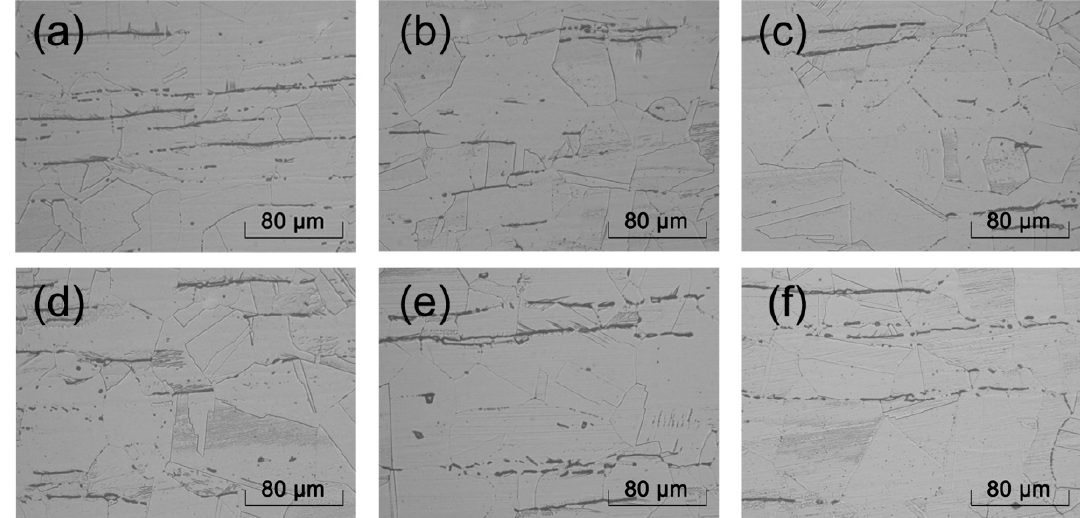
Figure 9. Optical micrographs of the AW and RW1–RW5 specimens by welding and repeated welding in the Gleeble weld-simulator: ( a ) AW; ( b ) RW1; ( c ) RW2; ( d ) RW3; ( e ) RW4; and ( f ) RW5.